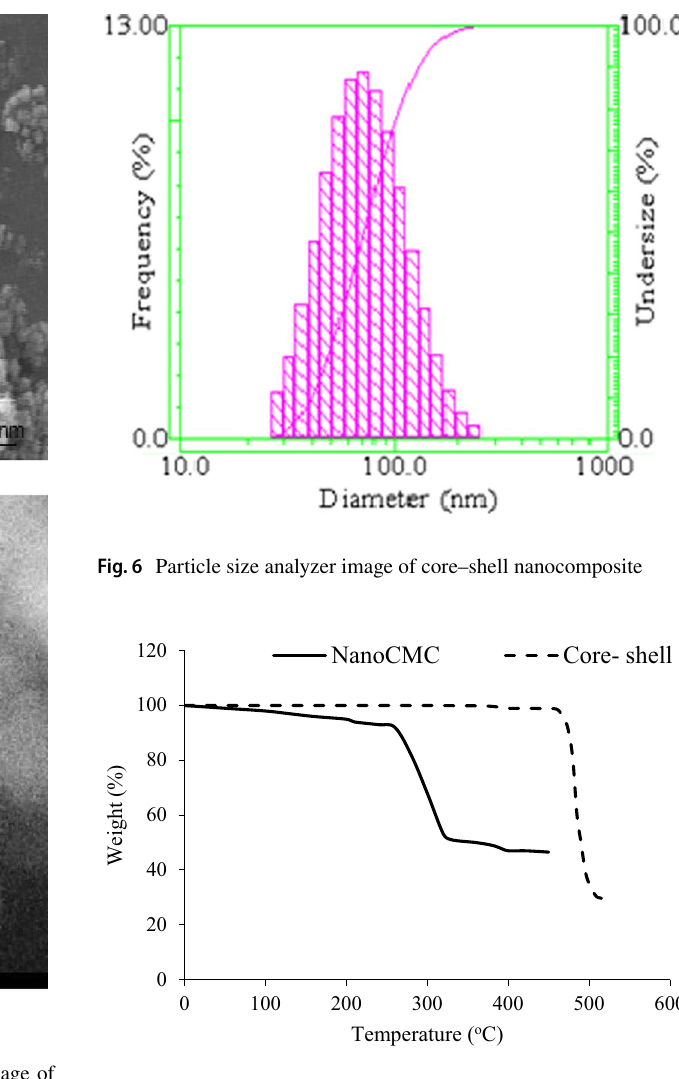
Fig. 7 Thermogravimetric curves of core–shell